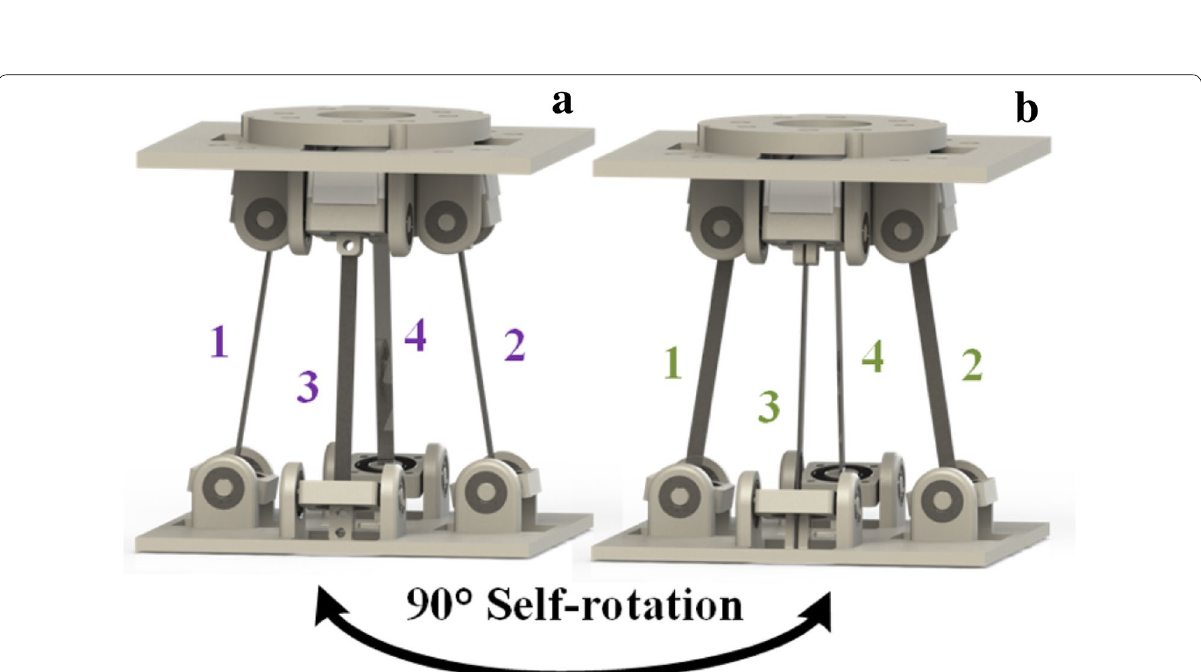
Figure 2 Two different statuses of the inner